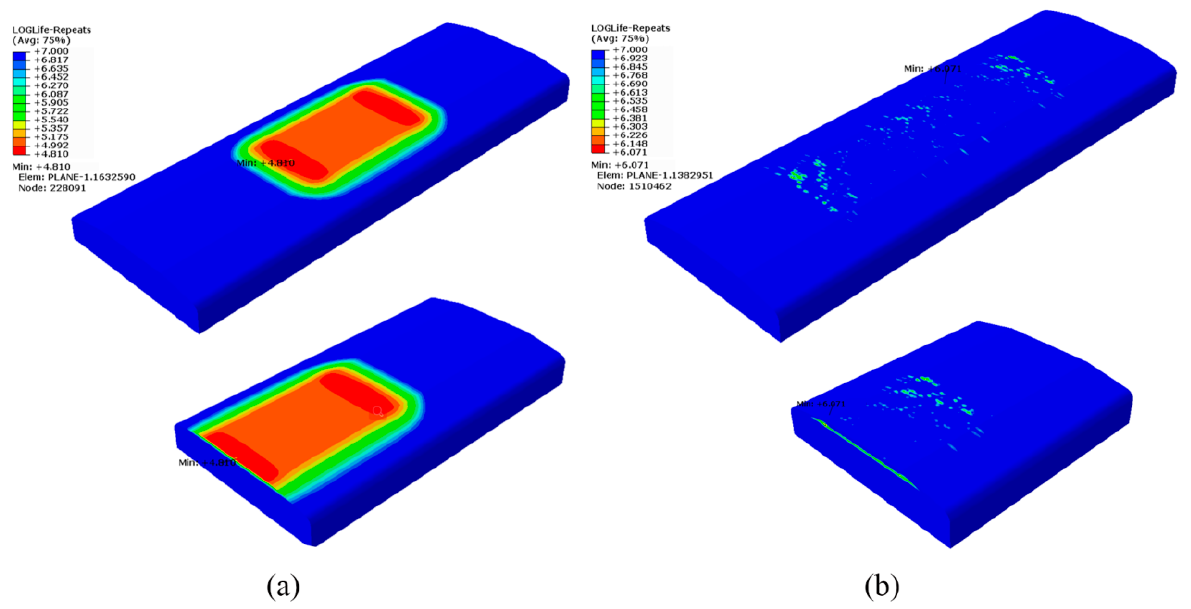
Figure 9. Logarithmic-form life nephograms of four-point bending fatigue: ( a ) specimen without LSP treatment; ( b ) specimen with LSP treatment.